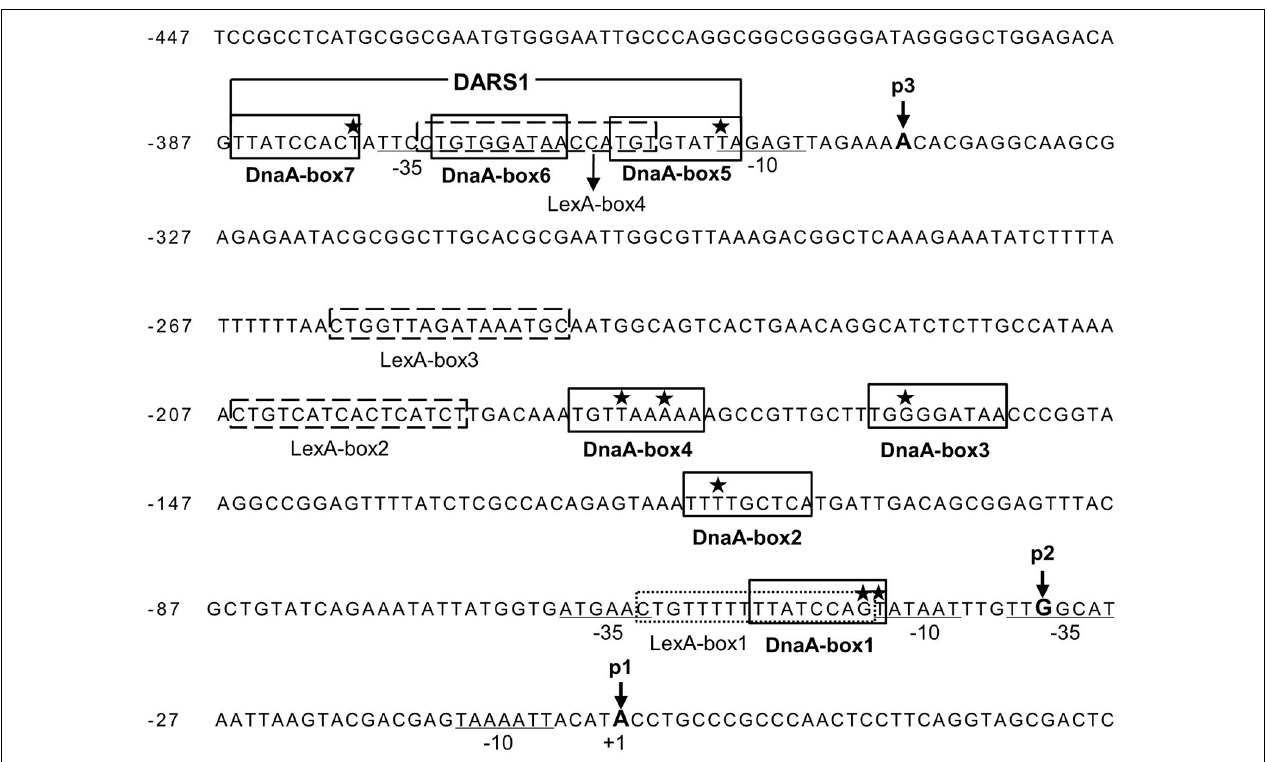
FIGURE 2 | The uvrB promoter cluster contains three promoters, seven potential DnaA-boxes and four LexA-boxes. Seven potential DnaA binding sites (DnaA-box1, 2, 3, 4, 5, 6, and 7) in the uvrB promoter region are boxed and labeled. DARS1 site consists of DnaA-box 5, 6, and 7. The stars represent the mismatched nucleotides to the consensus DnaA-box (TTA/TTNCACA). The potential LexA-boxes are boxed with a dashed line and labeled. The –35 and –10 sites of the promoters are underlined and labeled. The positions of nucleotides at the transcriptional starting site from promoter uvrB p1, p2 and p3 are indicated by p1, p2 and p3 with arrow, respectively, while p1 is numbered as +1 (Sancar et al., 1982; Arikan et al., 1986). The letters in bold indicate the transcriptional starting sites (+1) from different